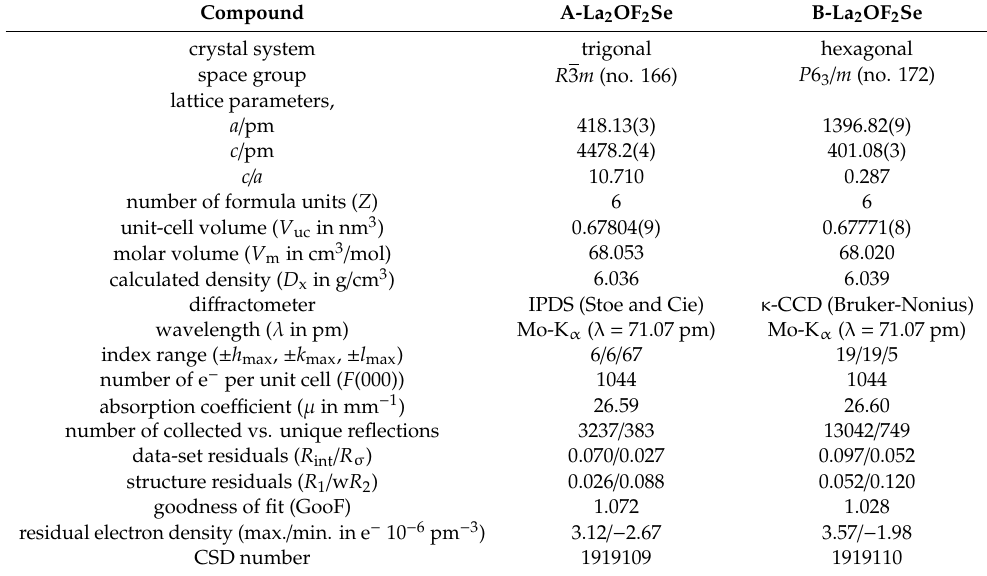
Table 1. Crystallographic data of A- and B-type La 2 OF 2 Se and their determination.